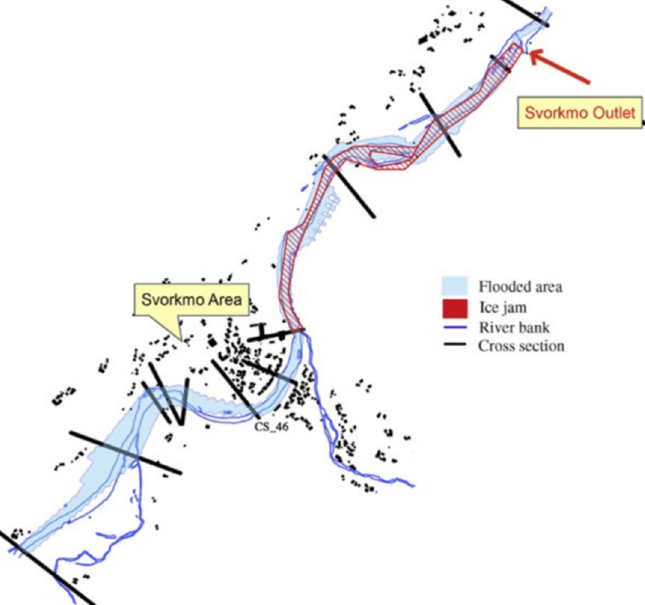
Figure 3. Ice jam on the Svormo River affecting the operation of a downstream hydro-power generation facility (from [12]).